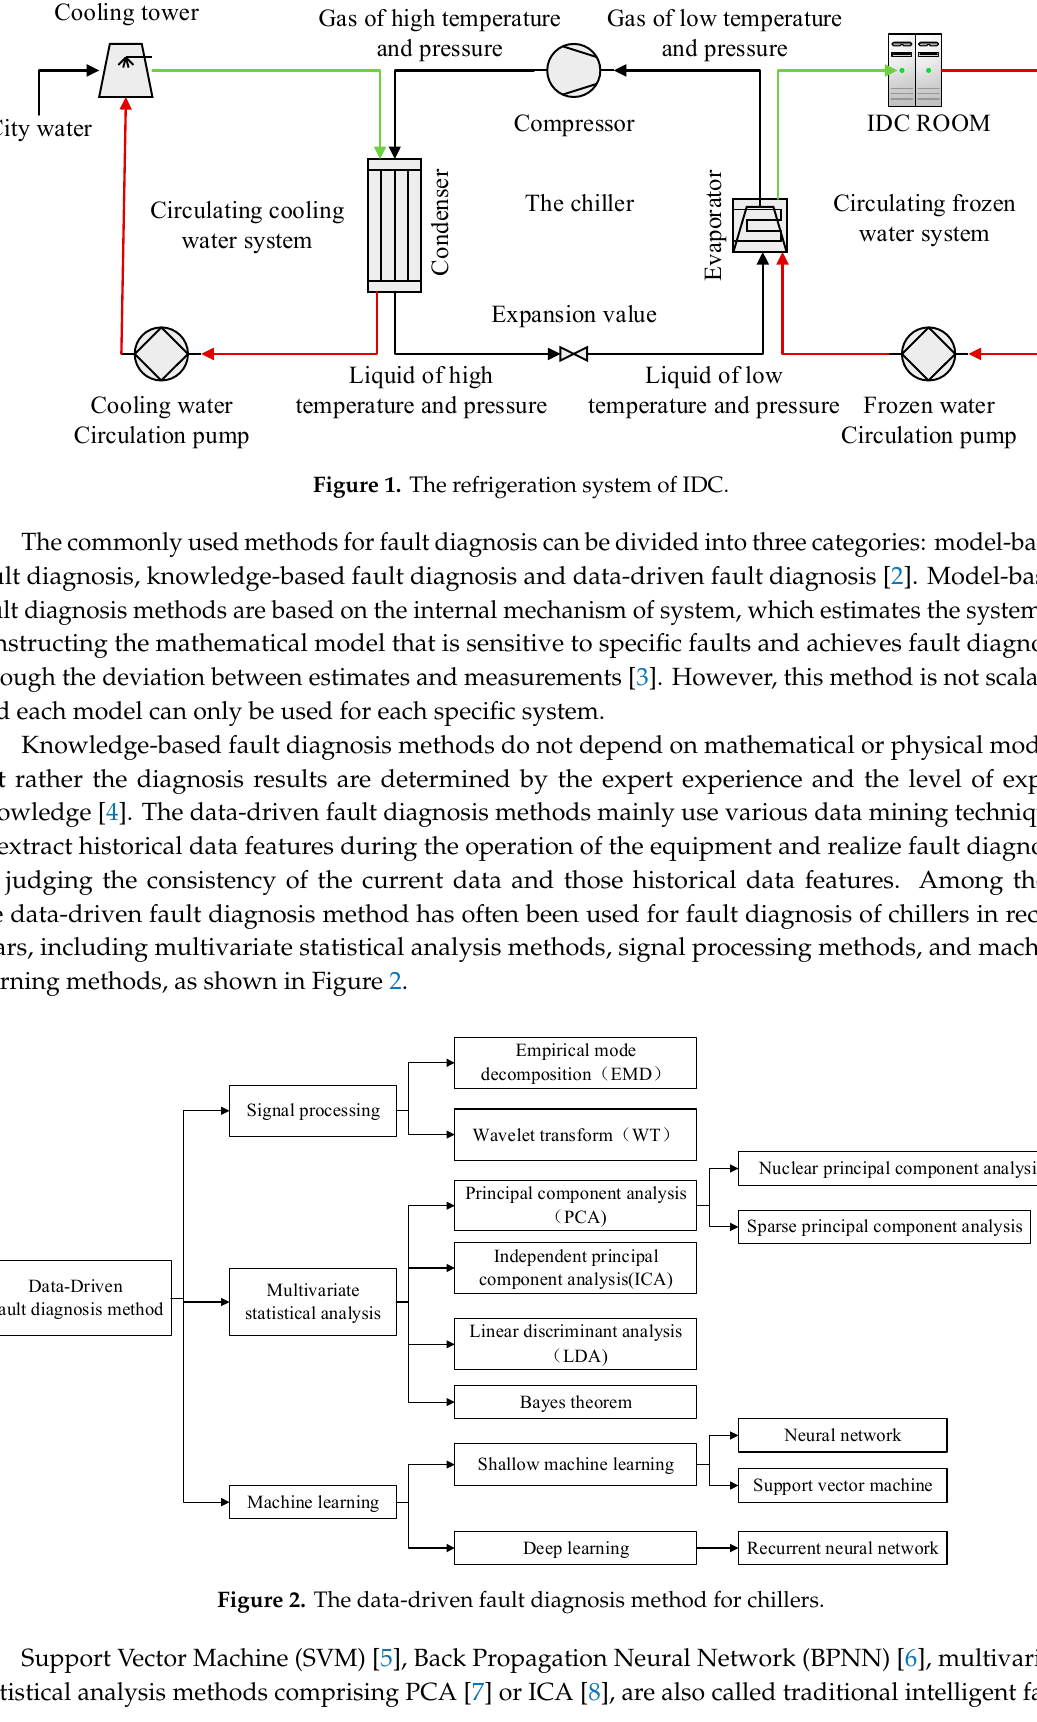
Figure 2. The data ‐ driven fault diagnosis method for chillers. Figure 2. The data-driven fault diagnosis method for